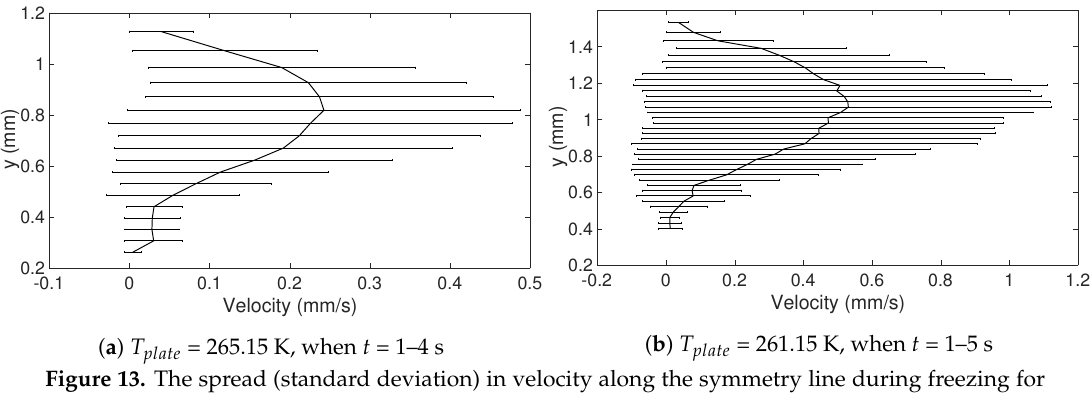
Figure 13. The spread (standard deviation) in velocity along the symmetry line during freezing for T plate = 265.15 K and 261.15 K when t = 1–4 s and t = 1–5 s, respectively, shown using error bars. The solid line is the mean velocity of all